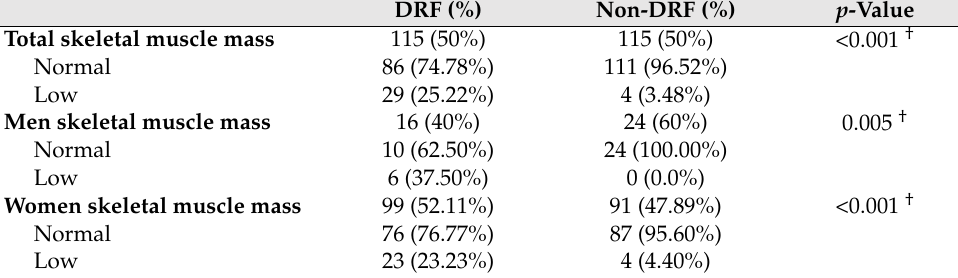
Table 3. Comparison of skeletal muscle mass by DRF.